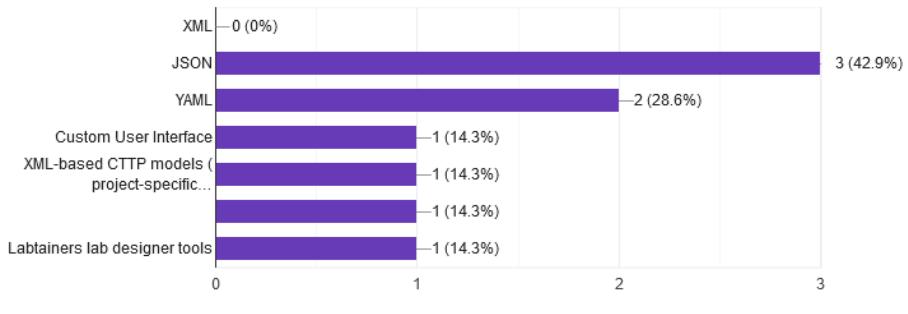
Figure 12. Tools to create cyber security